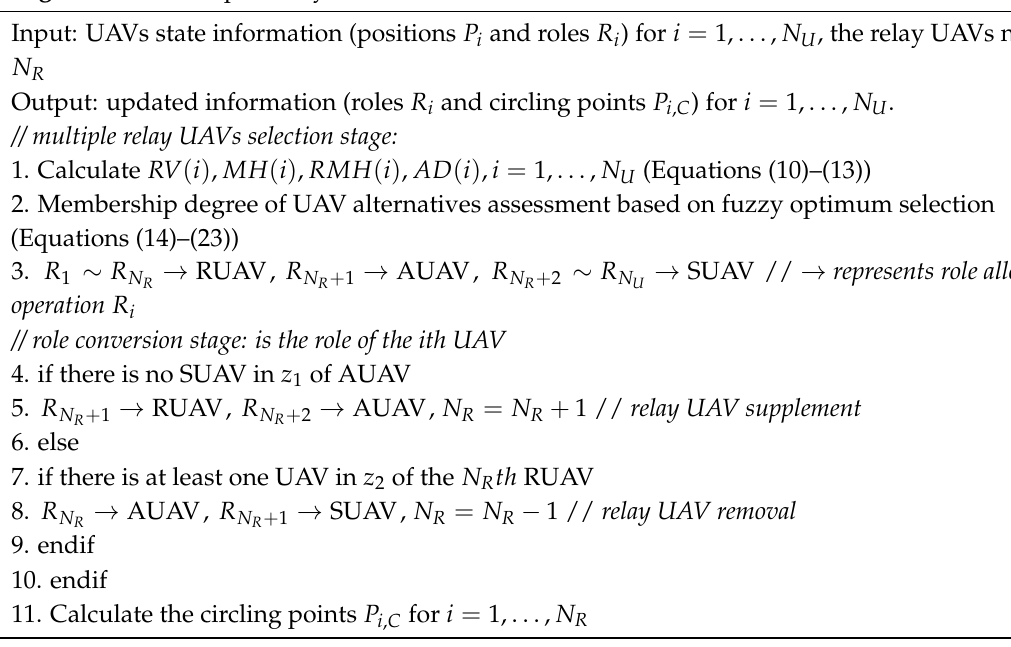
Algorithm 1. Multiple Relay UAVs Selection